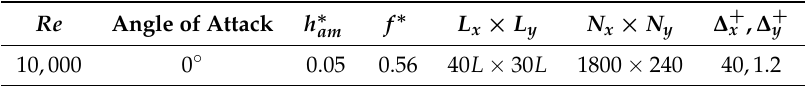
Figure 6. Computational domain and boundary condition of the validation case. Table 2. Computational parameters of validation case. (The superscript * is a non-dimensional variable with the chord length L and the airfoil forward propulsion speed U